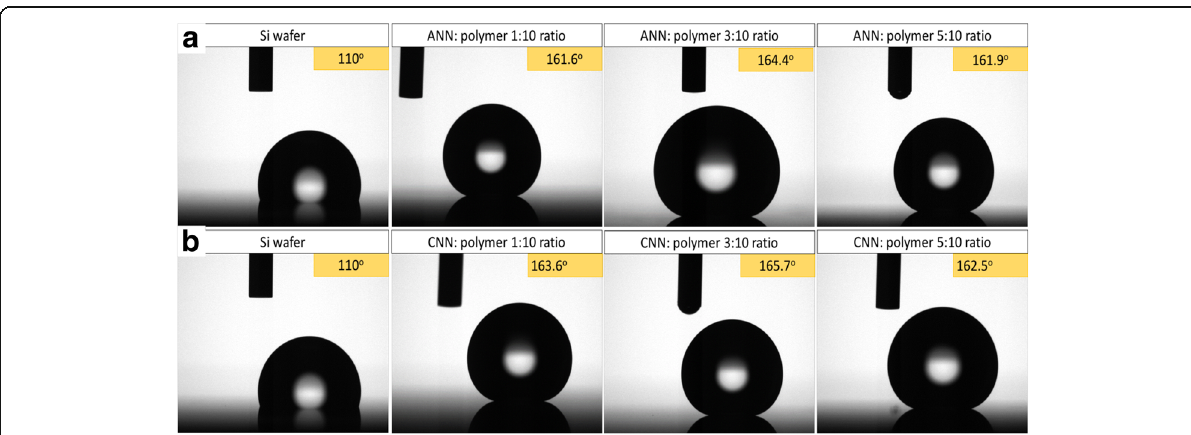
Fig. 7 Comparison of water contact angle measurements of silicon wafer with and without nanopillars formed by metal salt – polymer film. The nanopillars were fabricated by using a ANN:polymer. b CNN:polymer metal salt with different weight ratios show super-hydrophobic properties with above 160° contact angle with the surface